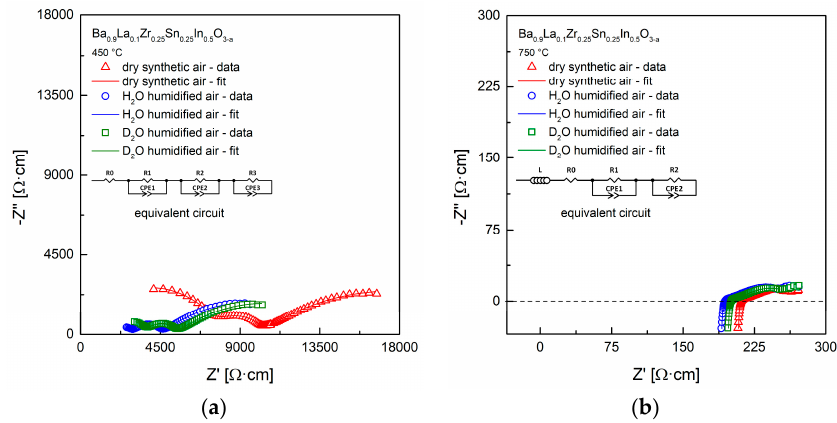
Figure 7. ( a ) Exemplary impedance data with fitting, measured in dry, H 2 O-, and D 2 O-containing synthetic air at 450 °C; ( b ) Exemplary impedance data with fitting, measured in dry, H 2 O-, and D 2 O-containing synthetic air at 750 °C.